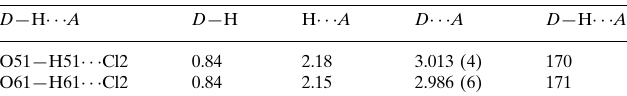
Hydrogen-bond geometry (A˚ , (cid:2)